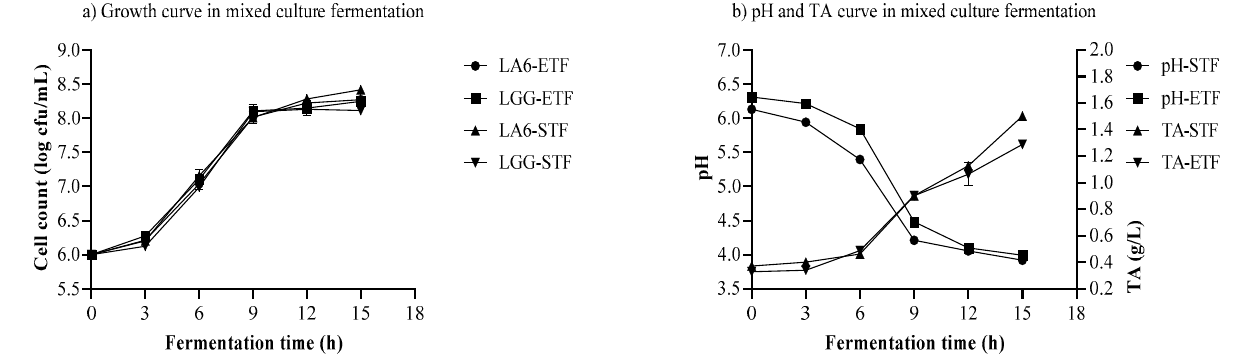
Figure 4. ( a ) Growth of Lactobacillus plantarum A6 and Lactobacillus rhamnosus GG, and ( b ) changes in pH & TA, (titratable acidity) in mixed culture fermentation; LA6-ETF & LGG-ETF, teff flour samples grown in Ethiopia inoculated with Lactobacillus plantarum A6 & Lactobacillus rhamnosus GG; LA6-STF & LGG-STF, teff flour grown in South Africa inoculated with Lactobacillus plantarum A6 & Lactobacillus rhamnosus GG; pH-ETF & TA-ETF, pH and TA found in teff flour samples grown in Ethiopia; pH-STF & TA-STF, pH and TA found in teff flour samples grown in South Africa.